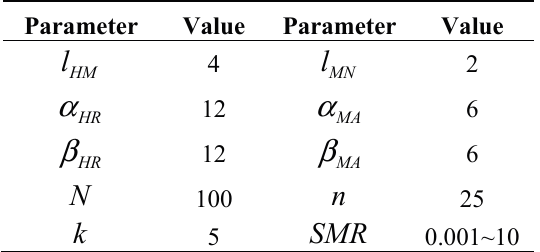
Table 2. Parameters and their values.